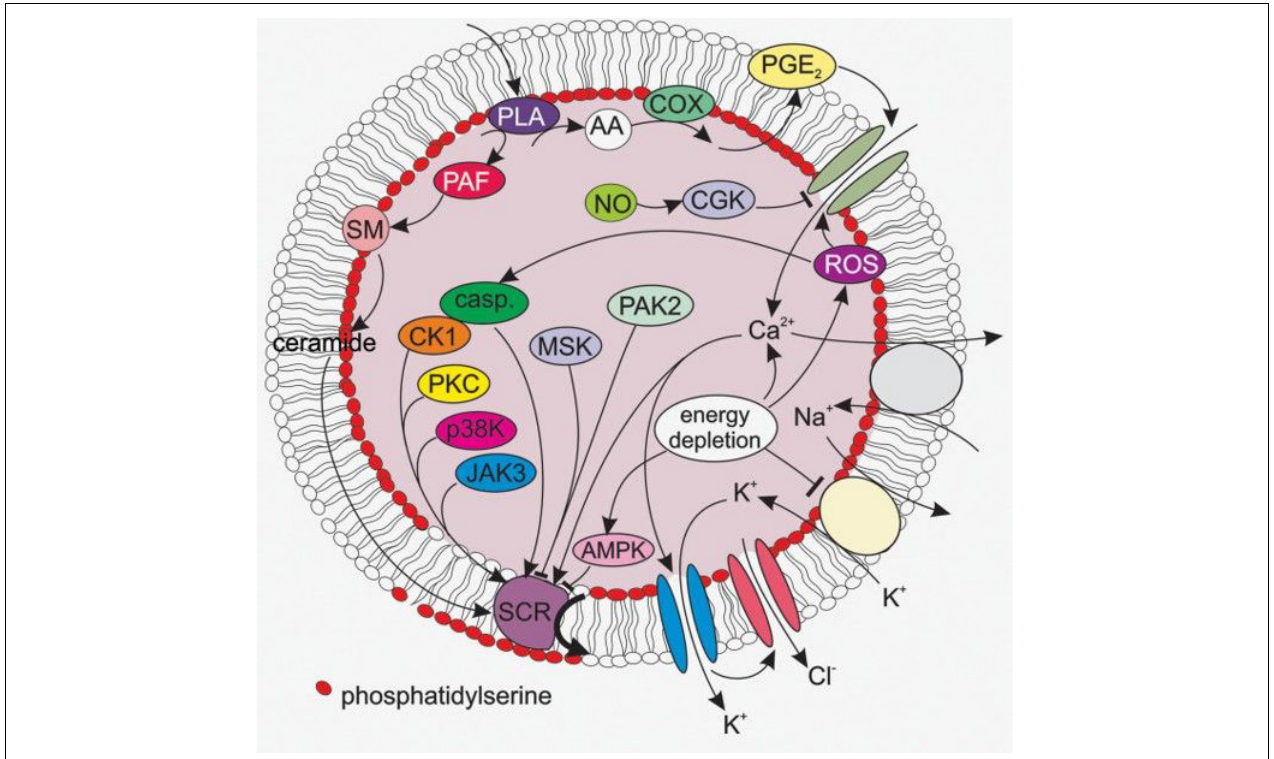
FIGURE 1 | A selection of signaling pathways relevant for eryptosis. AA, arachidonic acid; AMPK, AMP-activated kinase; casp, caspases; cGK, cGMP-dependent protein kinase 1; CK1, casein kinase 1; COX, cycloxygenase; JAK3, janus kinase 3; MSK, mitogen- and stress- activated kinase; PAK2, p21-activated kinase 2; p38 MAPK, p38 mitogen-activated protein kinase; PAF, platelet activating factor; PGE2, prostaglandin E2; PKC, protein kinase C; PLA, phospholipase A; SCR, scramblase; SM, sphingomyelinase. The figure was taken from the review by Lang E. et al. (2017).